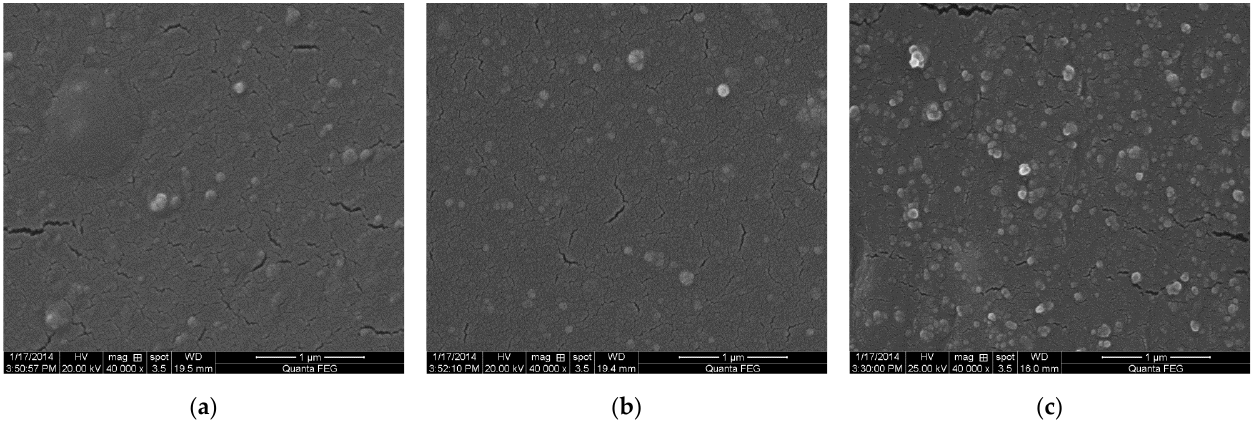
Figure 1. SEM images of freeze-fractured surface of CSDPF/NR vulcanizates, ( a ) C10, ( b ) C30 and (c) C50 .